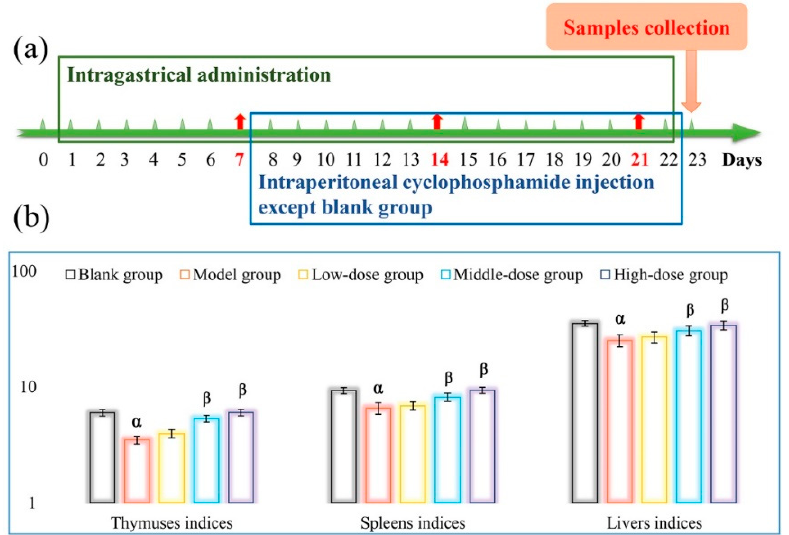
Figure 5. Flow chart of animal experiment ( a ) and effects of DOPs on the organ indices ( b ). Note: α p < 0.05 vs. the blank group; β p < 0.05 vs. the model group.